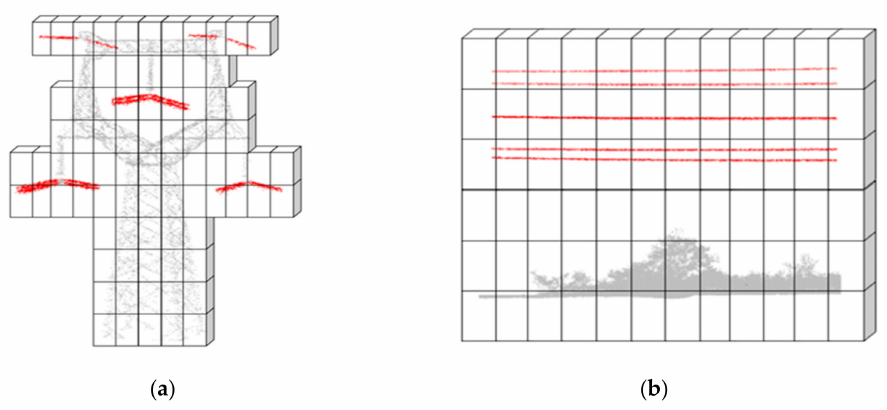
Figure 4. The voxels with different types of scenes. ( a ) Voxels with pylons and PTLs; ( b ) voxels with vegetation and PTLs.